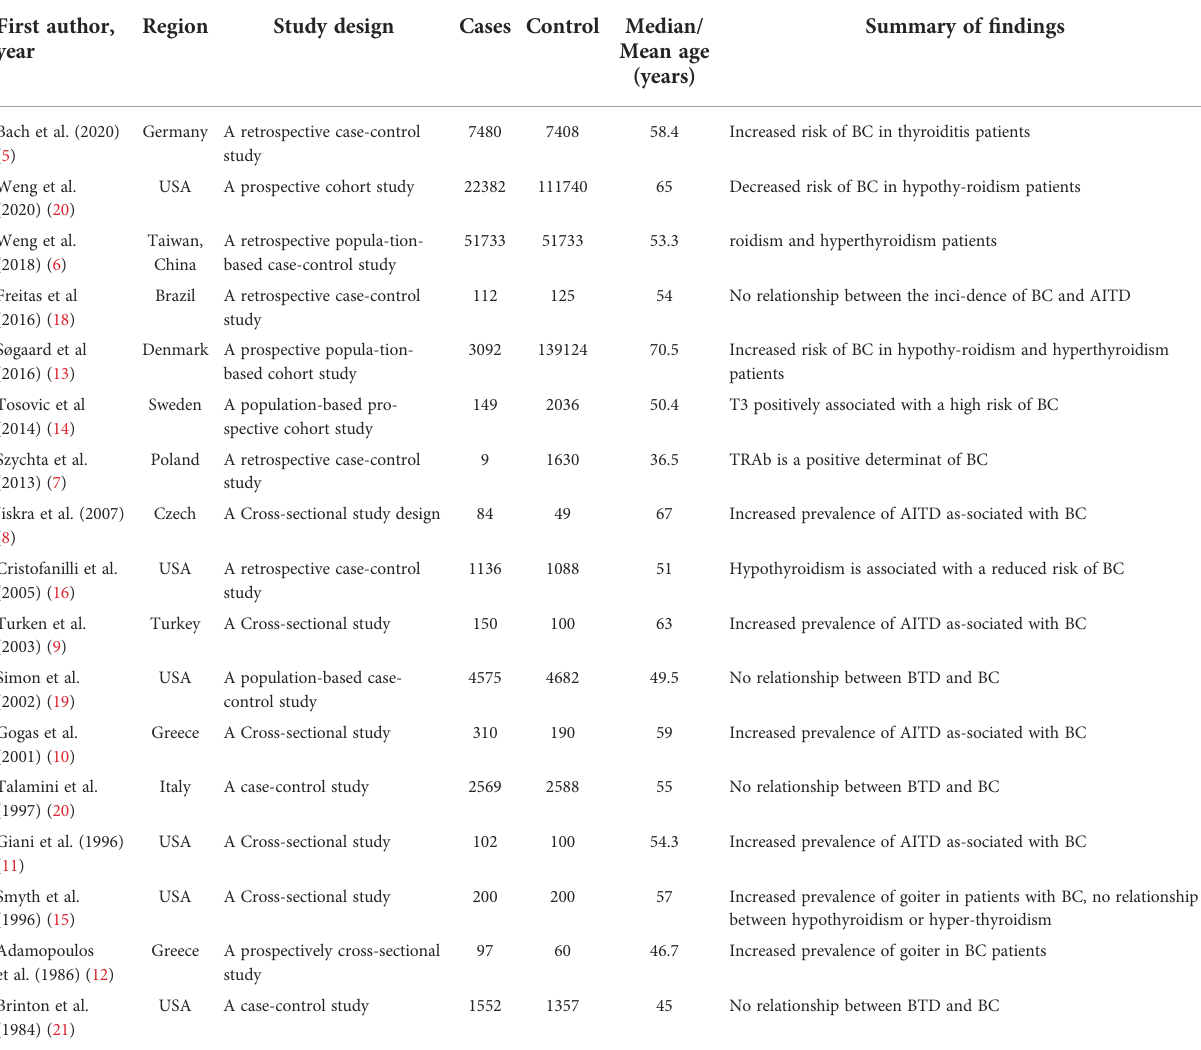
TABLE 1 Characteristics of the studies included in the